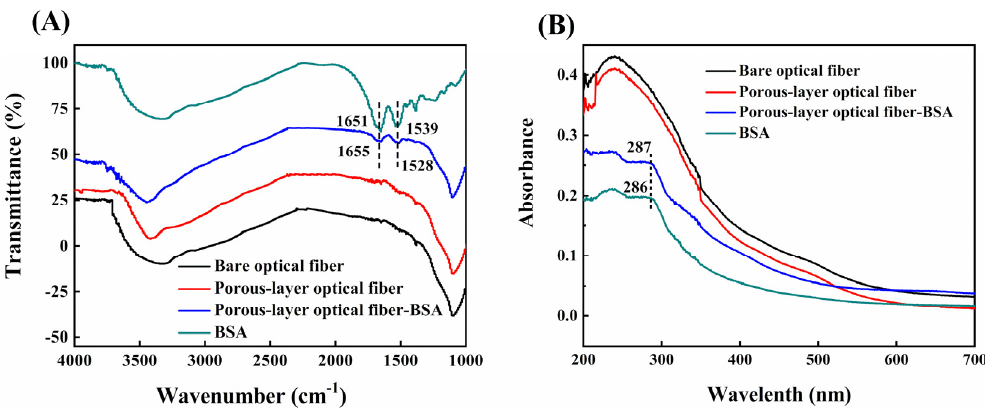
Figure 2. ( A ) FT-IR spectrum and ( B ) UV-vis spectrum of a bare optical fiber (black line), a porous-layer modified optical fiber (red line), a bovine serum albumin (BSA)-coated porous-layer modified optical fiber (blue line) and free BSA (green line).